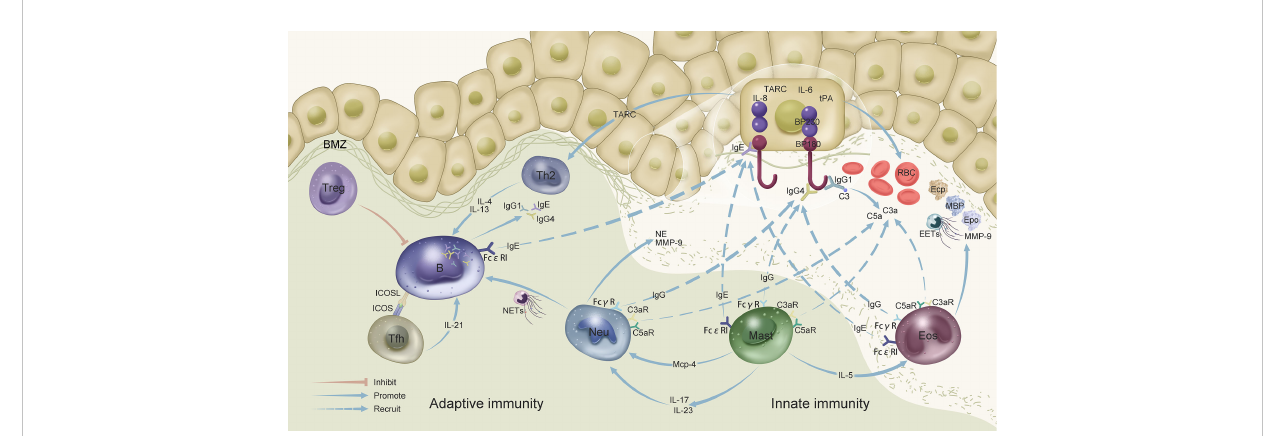
FIGURE 1 Innate and adaptive immunity in bullous pemphigoid: B cells produce IgE, IgG1, and IgG4 autoantibodies to bind antigens to the BMZ. Antigen – IgG1 binding to the BMZ triggers complement activation. C3 activation at the dermal-epidermal junction leads to the formation of chemotactic peptides (C3a and C5a), which recruit neutrophils and eosinophils and induce mast cell degranulation, thereby contributing to blister formation. Antigen – IgG4 binding leads to the recruitment of neutrophils and eosinophils and, consequently, to the release of proteolytic enzymes. BP180-speci fi c IgG autoantibodies modulate IL-6, IL-8, and tPA expression in human keratinocytes. TARC/CCL17 secreted by keratinocytes can recruit and activate Th2 cells. IgE autoantibodies amplify the in fl ammation in BP by interacting with eosinophils, mast cells, and B cells. IgE autoantibodies could also induce BP180 internalization in basal keratinocytes, thereby suppressing their adhesion. Tfh cells promote the production of high-af fi nity autoantibodies from B cells via regulation by IL-21 and ICOS-ICOSL. Activated Th2 cells secrete IL-4, which regulates IgG isotype and IgE switching. Mast cells activated by IgE degranulate and release IL-5 to promote eosinophil accumulation and activation. Eosinophils are attracted to the BMZ by IgG autoantibodies and complement fi xation, and degranulate after interacting with IgE. Eosinophils secrete EETs and toxic granule proteins, including ECP, MBP, EPO, and MMP-9, which are involved in the local in fl ammatory cascade. In addition, activated mast cells release MCP-4, which activates neutrophils. Activated neutrophils release cytokines and proteases, including NE and MMP-9, which degrade the extracellular matrix and split dermal-epidermal junctions. Neutrophils also release NETs and stimulate autoantibody production by B cells. Neutrophils and mast cells release IL- 17 and IL-23, thereby signi fi cantly enhancing MMP-9 and NE production by neutrophils. tPA, a component of the plasminogen/plasmin system secreted by keratinocytes, may interact with MMP-9 or NE to promote in fl ammation. What ’ s more, tPA, MMP-9, NE and eosinophils all could lead to the activation of coagulation system, inducing thrombotic and bleeding risk of skin. BMZ, basement membrane zone; C3, complement 3; EETs, eosinophil extracellular traps; MMP-9, matrix metalloproteinase-9; NE, neutrophil elastase; NETs, neutrophil extracellular traps; MCP-4, mast cell protease-4; C3a, activated third component of complement; C5a, activated fi fth component of complement; C3aRs and C5aRs, C3a and C5a receptors, respectively; RBC, red blood cell; EOS, eosinophil; Th, helper T cell; Tfh, T follicular helper cell; Neu, neutrophil; B, B cell; Mast, mast cell; MBP, major basic protein; ECP, eosinophil cationic protein; EPO, eosinophil peroxidase; TARC, thymus and activation-regulated chemokine; tPA, tissue plasminogen